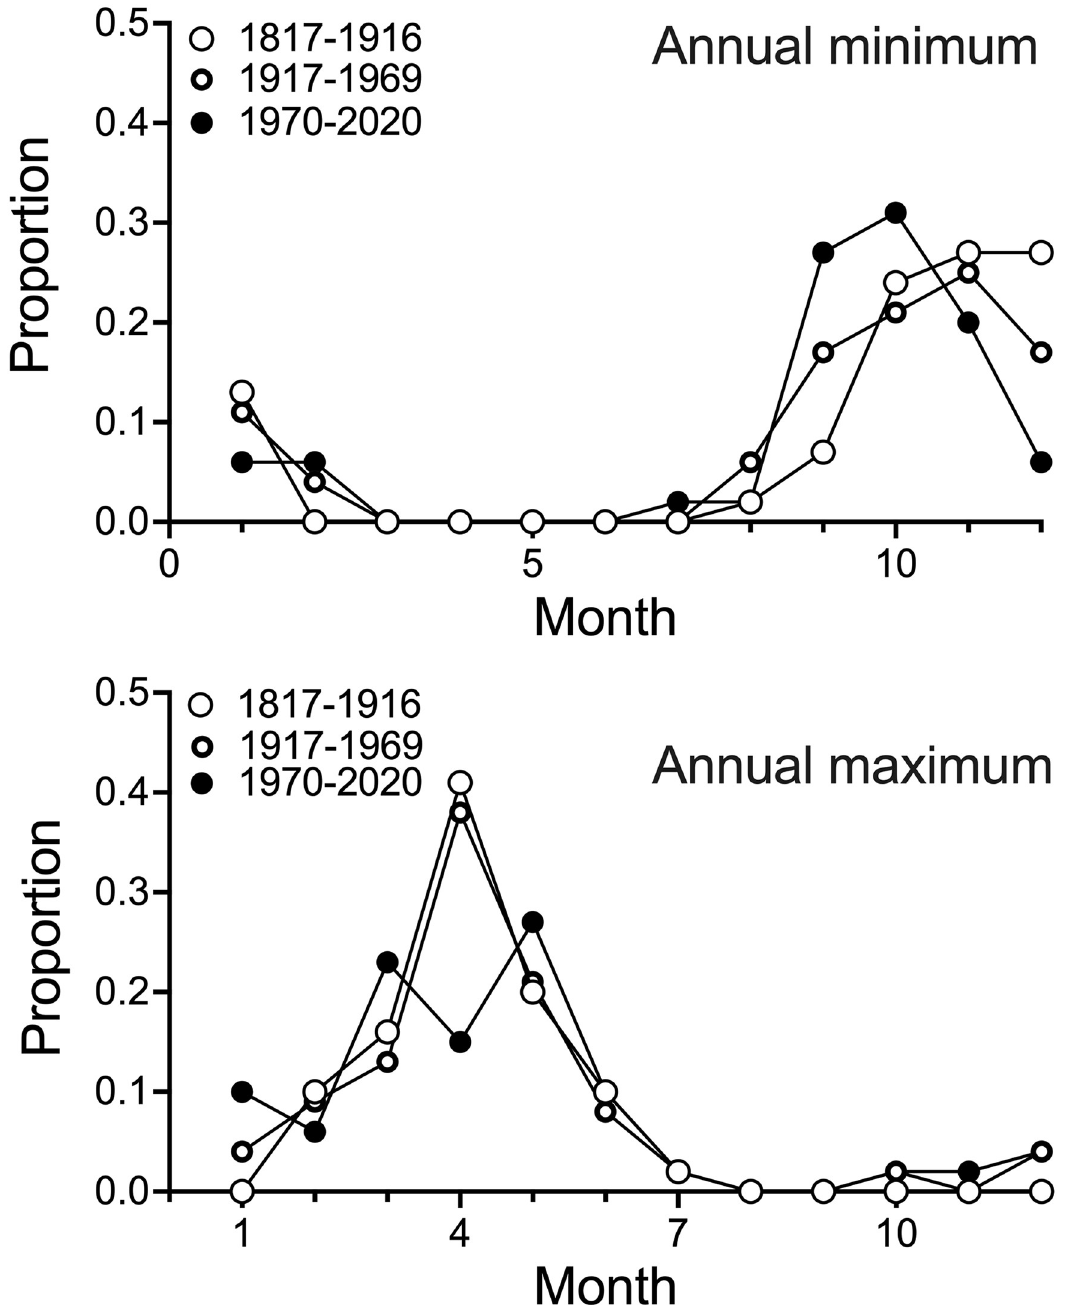
Fig 4. The monthly proportion during the year for the annual minimum (upper panel) and maximum (lower panel) discharge (m 3 sec -1 ) at Vicksburg, MS, from 1817 to 1916, from 1917 to 1969, and from 1970 to